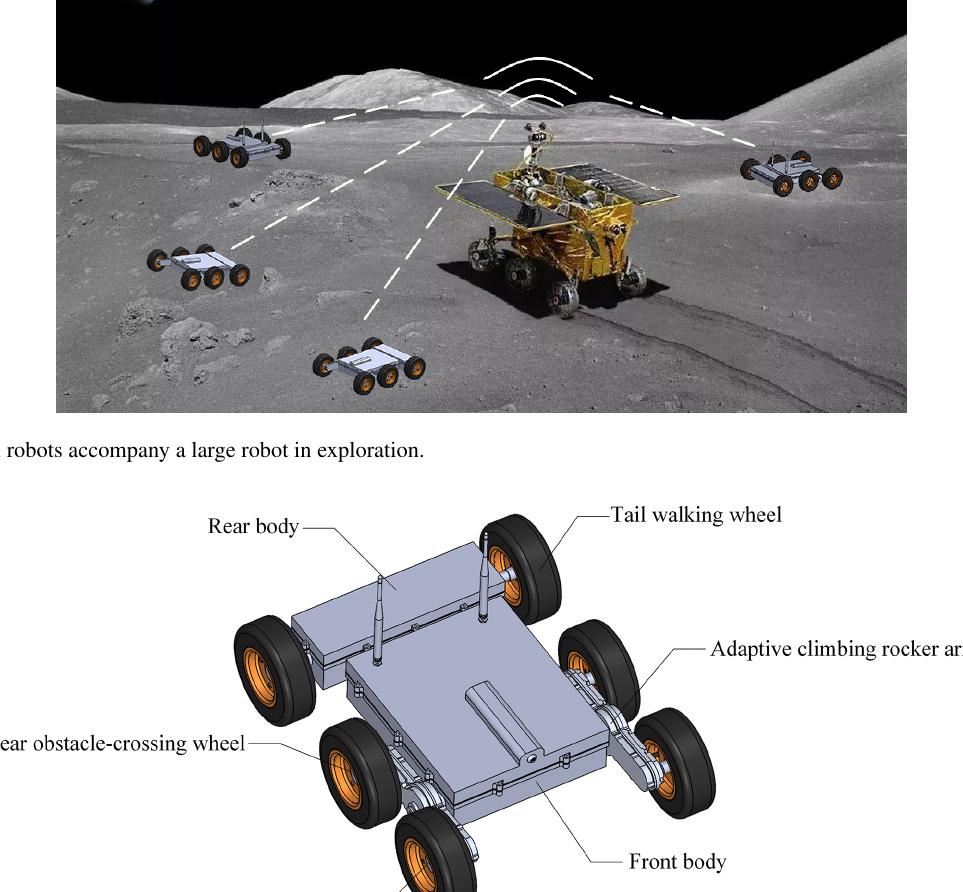
climbing rocker arms and push the robot to climb the